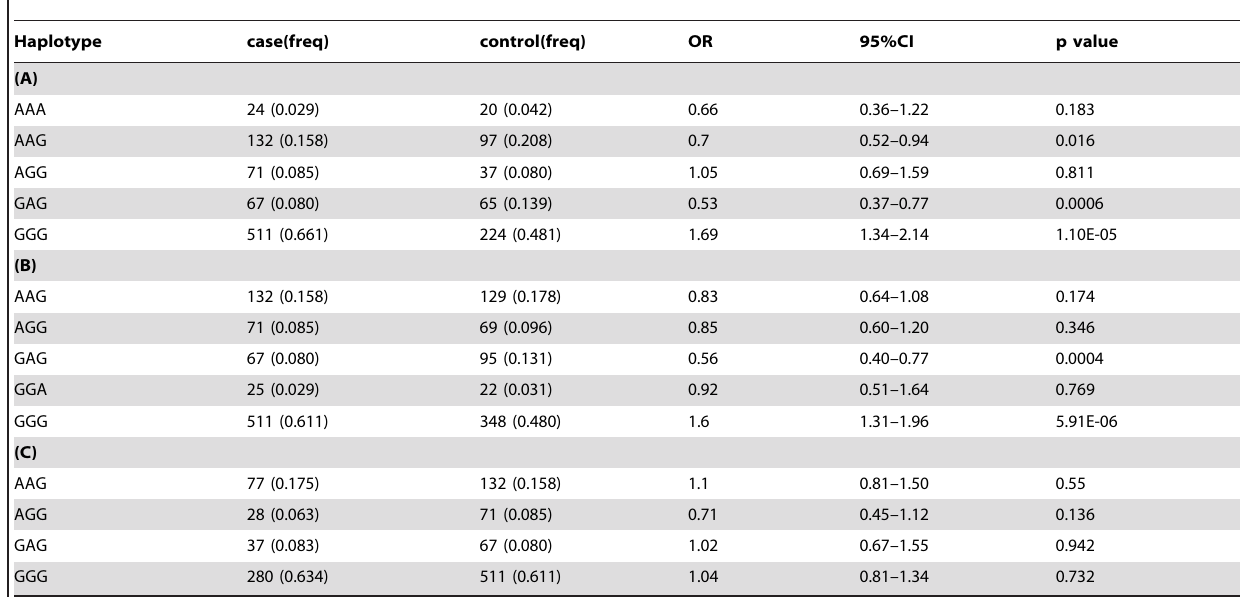
Table 4. Haplotype analysis of rs3077, rs9277535 and rs7453920 with HBV susceptibility, seroclearance and HCC